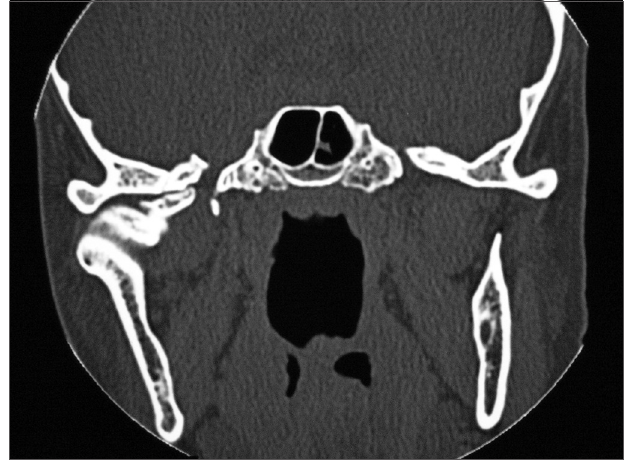
Figura 5. TC vista coronal: ostema periférico em côndilo mandibular